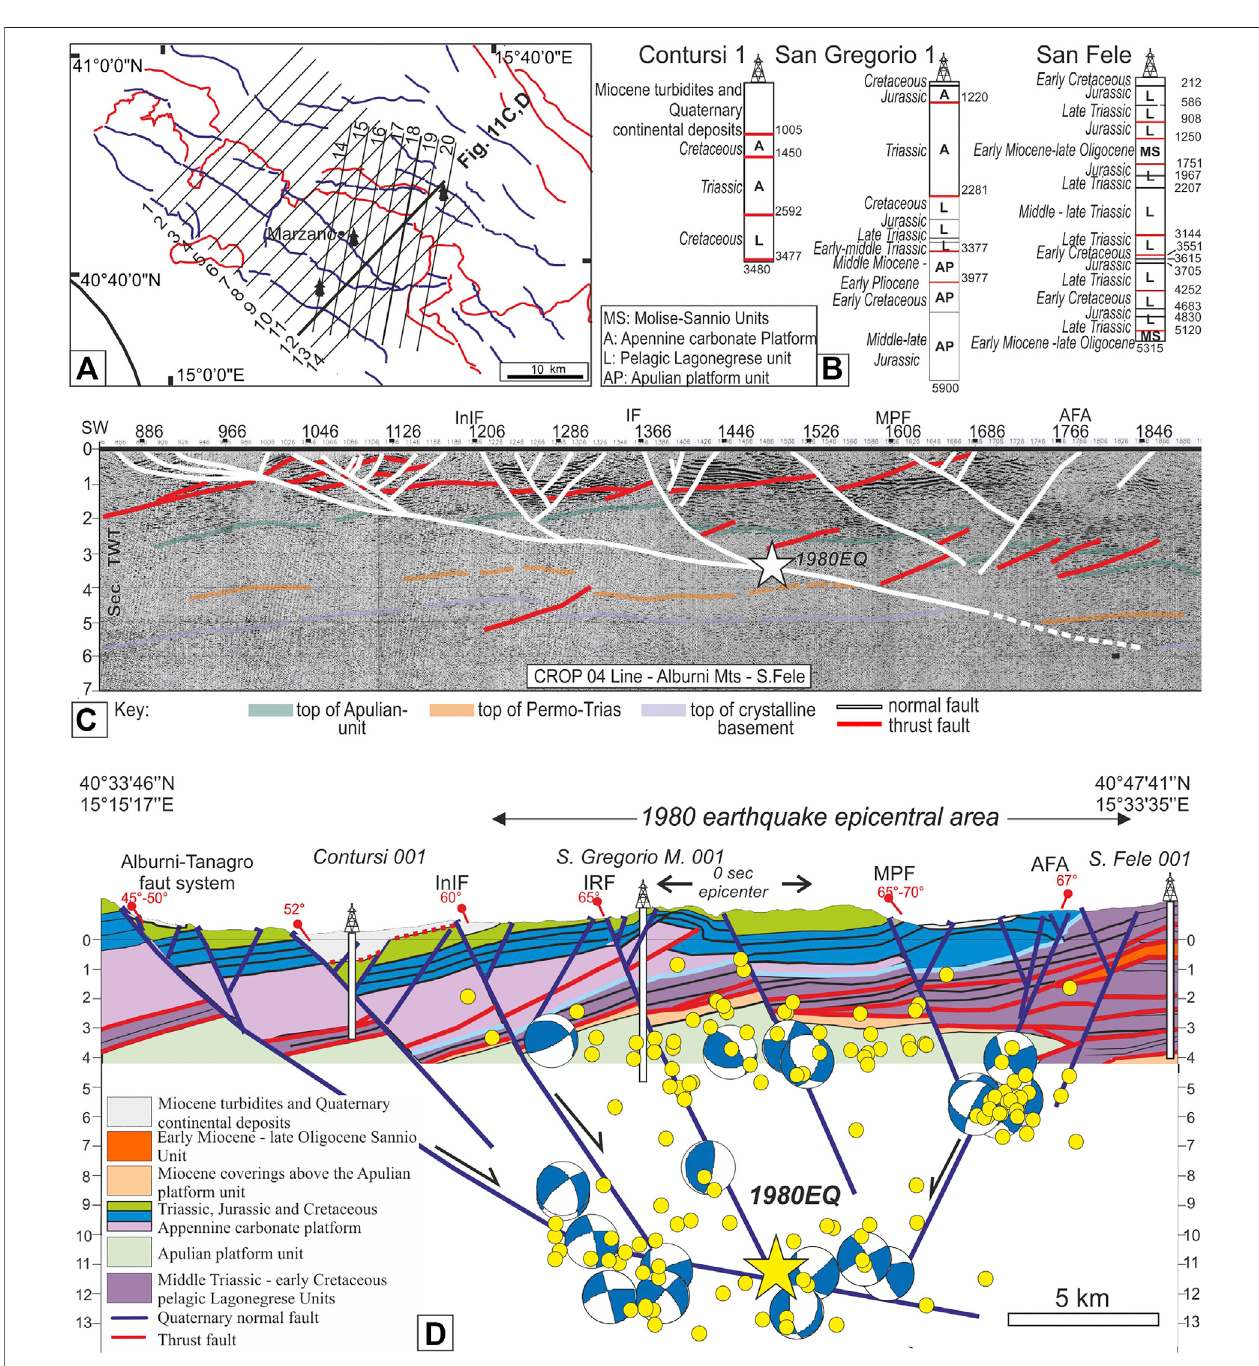
FIGURE 11 | Depth interpretation of the outcropping 1980-EQ faut pattern along the trace of the CROP-04 near vertical seismic pro fi le. (A) Location map with the trace of the CROP-04 line; the serial transects used to build the 3D faut model of Figure 12 are reported. (B) Contursi, San Gregorio Magno 001 and San Fele wells stratigraphy. (C) Interpretation of the CROP-04 pro fi le, along the Tanagro – S. Fele transect (from Brozzetti, 2011). (D) Geological cross-section along the CROP-04 line, oil wells, seismicity (yellow circle from De Landro et al., 2015) and focal mechanisms from De Matteis et al., 2012 (semi-width 5 km).